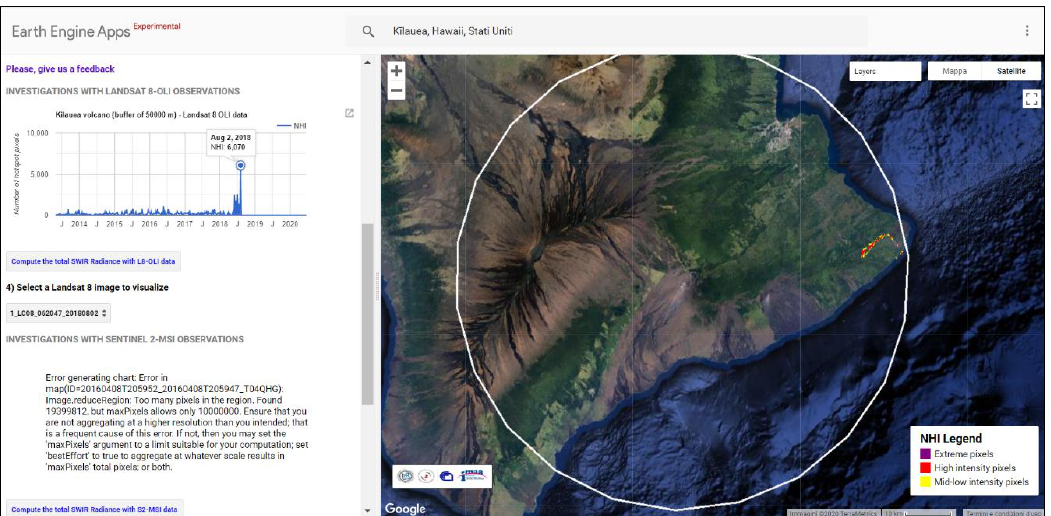
Figure 9. Lava flow at the lower East rift zone (LERZ) of Kilauea (19°25′15.95″N 155°17′12.34″W) volcano, investigated by setting a distance buffer of 50 km (see white circle). Note that the tool generated only outputs from Landsat-8 OLI data due to Google Earth Engine (GEE) restrictions (see text).